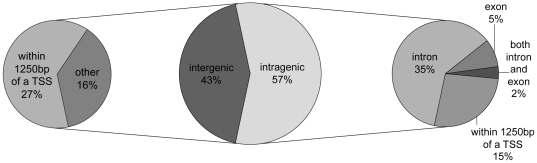
Breakdown of HSF-binding site by location.Fewer than 1/3 of all HSF-binding sites are located in gene promoters with the promoters of major heat-inducible genes accounting for less than 5% of these sites (not shown). The majority of HSF binding sites are instead located in transcribed regions of the genome with introns accounting for the largest proportion of HSF targets. Fifteen percent of all sites are somewhat ambiguous in definition as they occur within transcribed regions but are also in the vicinity of a transcription start site (TSS).